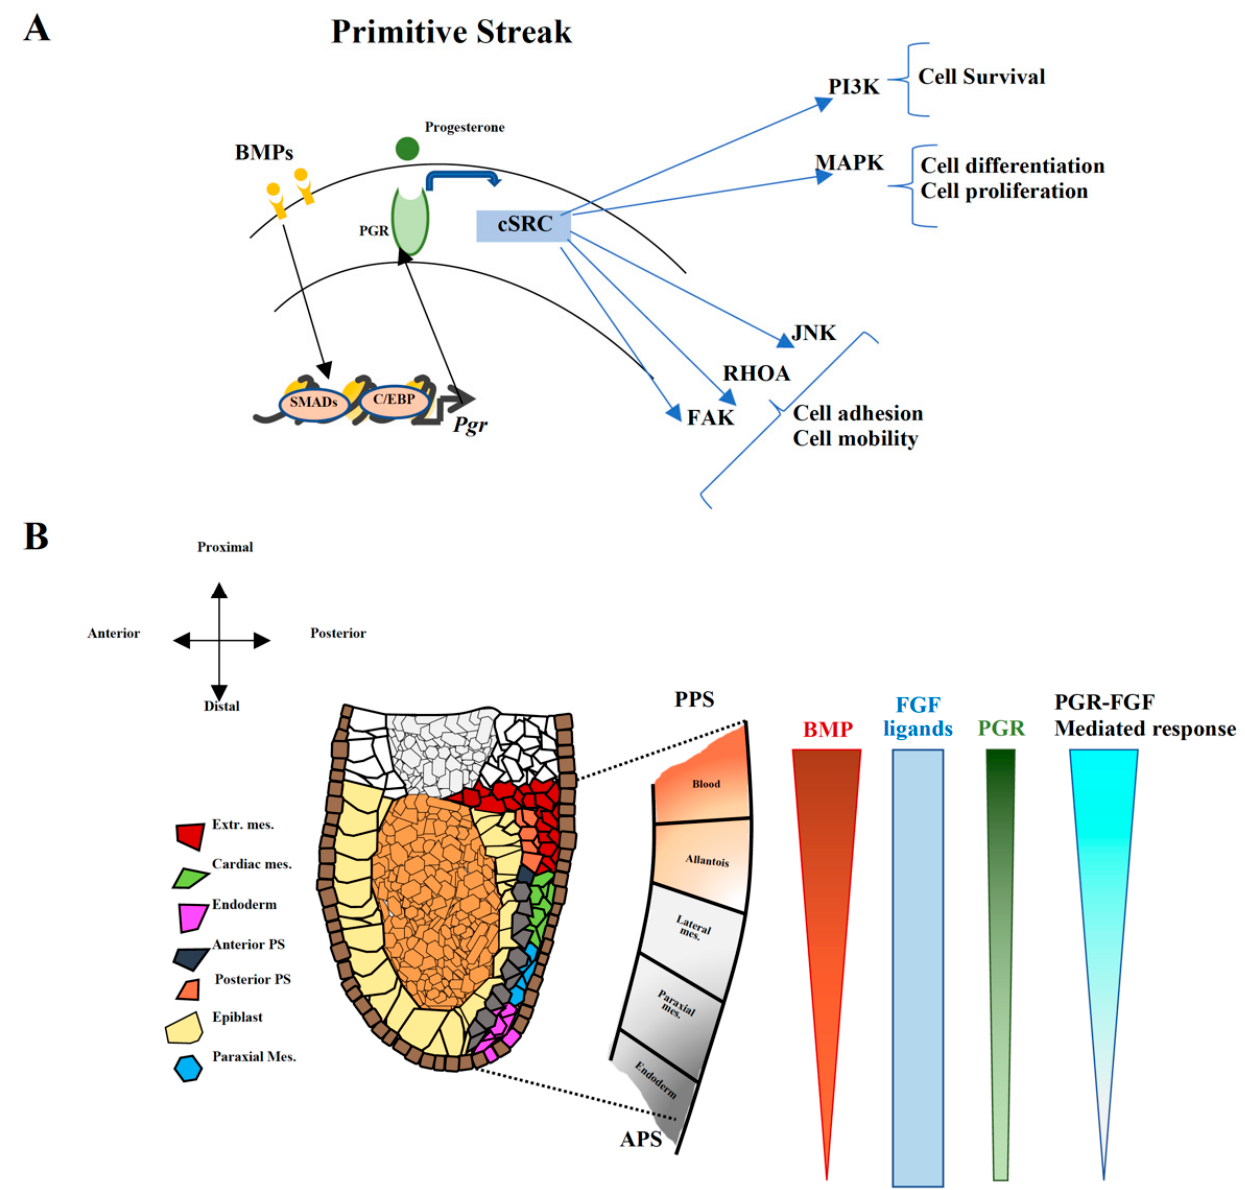
Figure 7. BMP-induced PGR expression fine-tunes and amplifies FGF response during cell specifi- cation. ( A ) Illustration showing a proposed molecular mechanism of PGR function during differen- tiation. As described previously, BMP induces PGR upregulation [50]. PGR, in turn, interacts with c-SRC [24] and activates its downstream targets: PI3K, MAPK, JNK, RHOA and FAK, thus influ- encing cell survival, differentiation, proliferation, adhesion, and motility. ( B ) Illustration depicting ligand gradients described in the gastrulating mouse embryo at around E6.5 with BMP expressed in posterior–anterior gradient and modulating the expression of PGR along the same axis. We pro- pose that this PGR gradient establishes a gradient for FGF response in the early mouse embryo, as shown in A, thus influencing cell fate decisions during mesoderm development, specifically ExM and CM